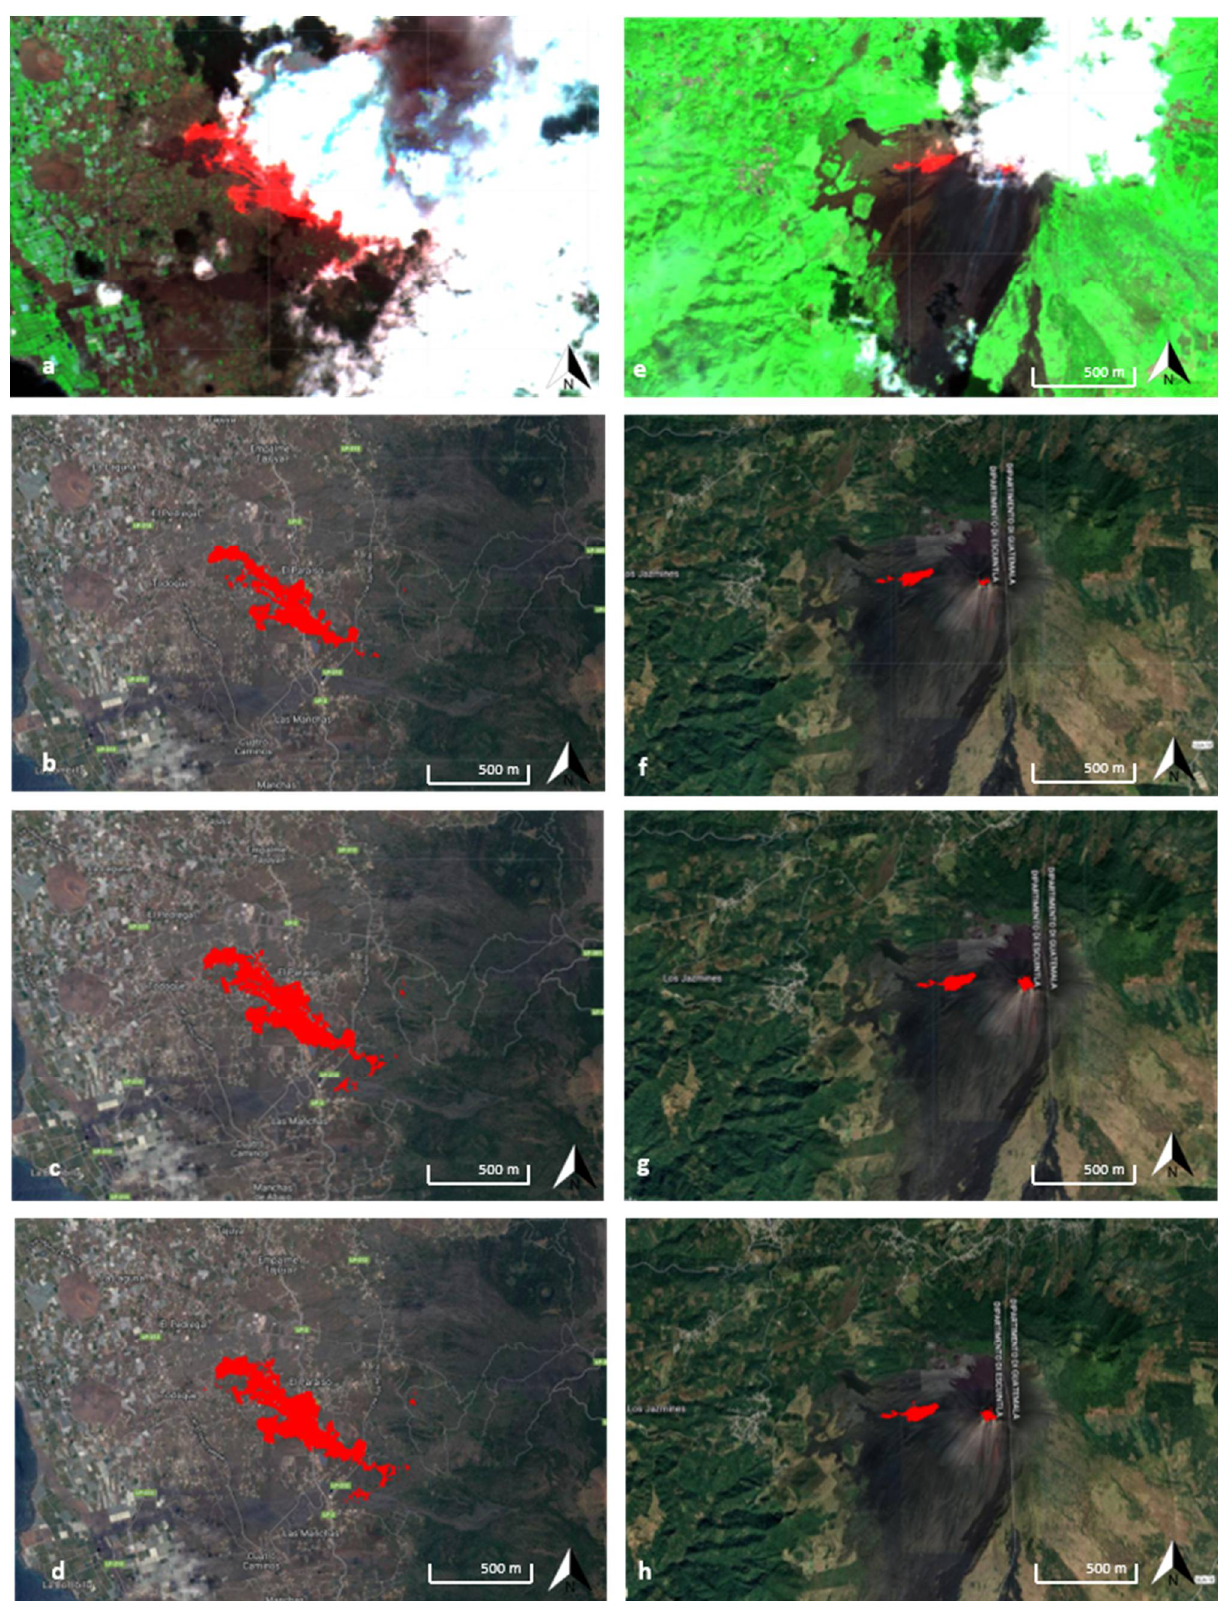
Figure 5. Test set: S2-MSI False RGB (B12-B8A-B5) image, the fixed threshold, the RF (NIR and SWIR) and the RF (VIS, NIR, and SWIR) outcomes for Etna on the 21 February 2021, ( a – d ) and Stromboli on the 27 July 2019 ( e – h ). All the images were captured via Google Earth Engine.